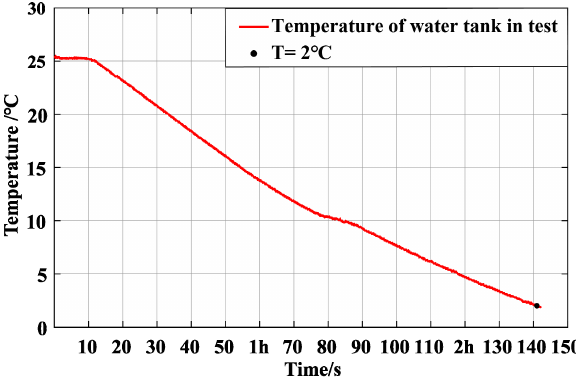
Figure 15. Temperature curve of water in tank.